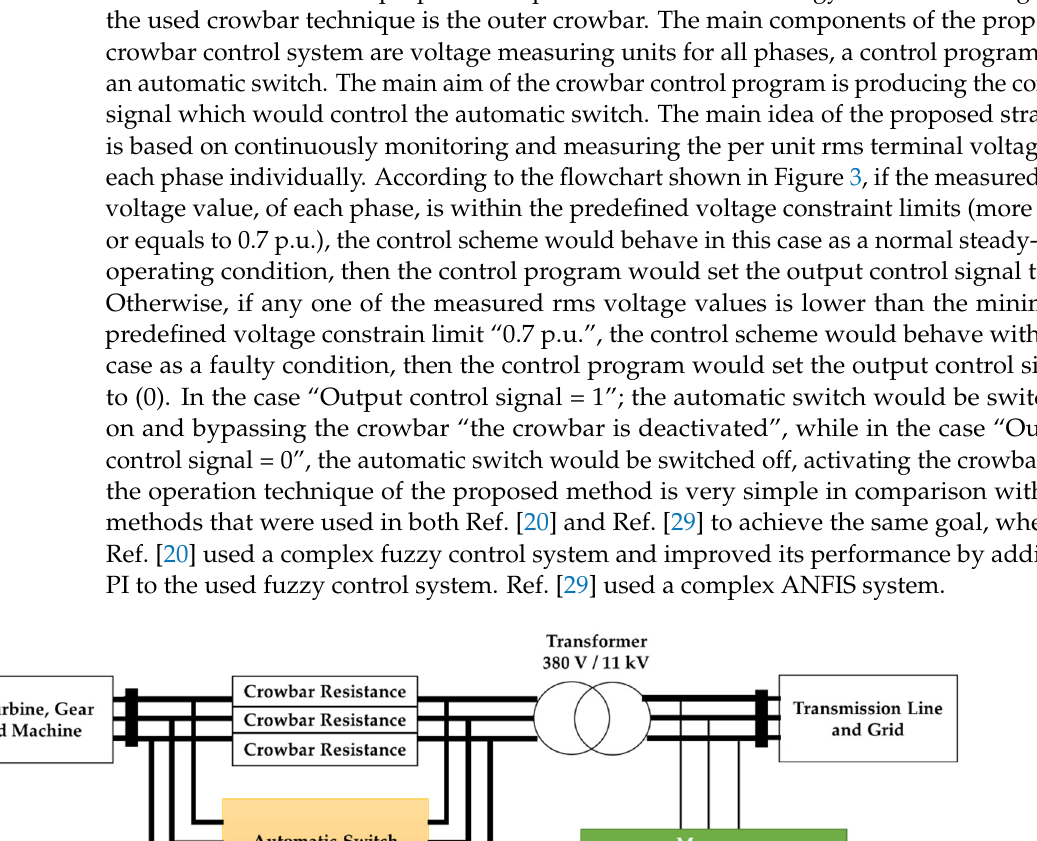
Figure 3. Flow chart of the proposed control for the crowbar.